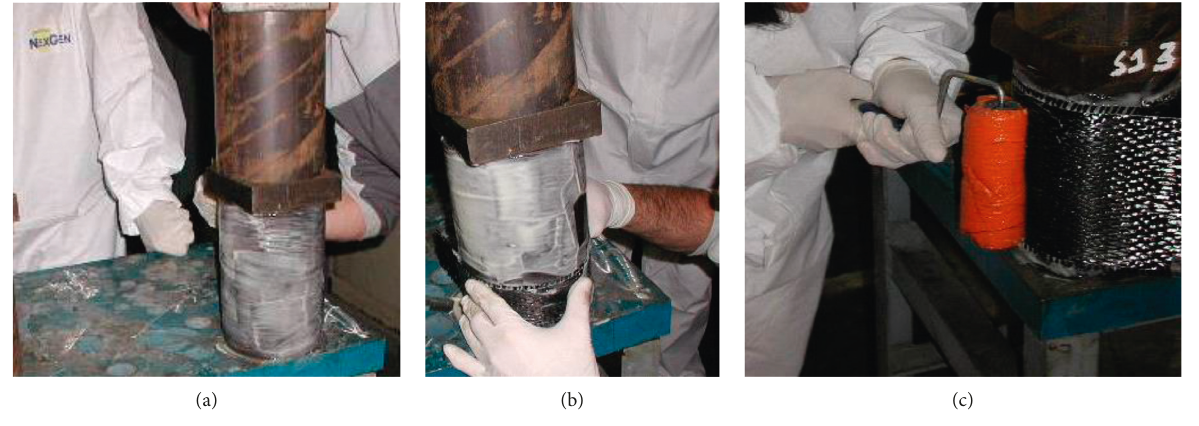
Figure 1: Bonding of CFRP.